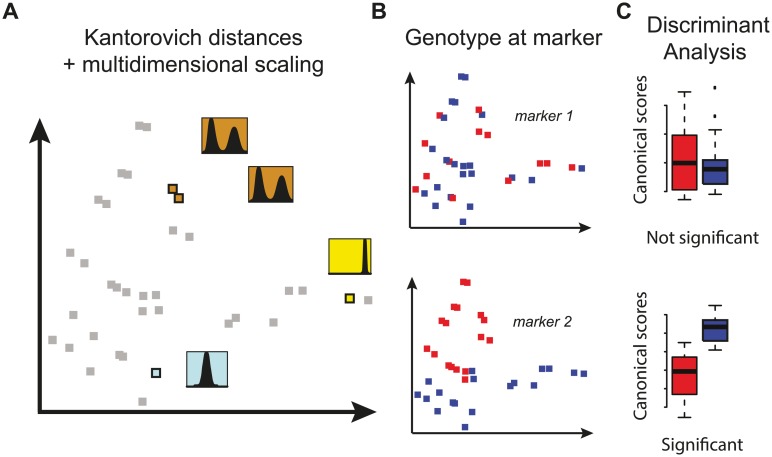
Principle of scPTL mapping.A cohort of multi-cellular individuals (or unicellular clones) with differing genotypes is used. For each individual (or clone), a cellular trait X is measured on a population of cells, and the observed distribution of X corresponds to the 'phenotype' of the corresponding individual. A) Kantorovich distances are computed for all pairs of individuals. The resulting distance matrix is used to place individuals in a multidimensional space. Proximity of individuals (grey and colored squares) in this space reflects comparable phenotypes (distributions in insets). B) Individuals are 'labeled' (blue vs. red) by their genotype at one genetic marker. C) A canonical discriminant analysis is performed to test if the genotype at the marker discriminates individuals in the phenotypic space. In the examples displayed, genetic linkage is significant at marker 2 but not at marker 1.